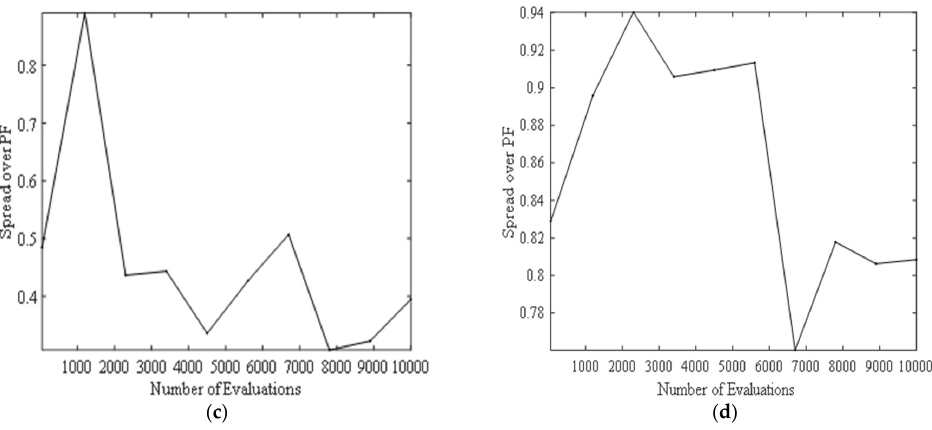
Figure 6. Solution Spread over the PF for ( a ) Case 1, ( b ) Case 2, ( c ) Case 3, ( d ) Case 4.